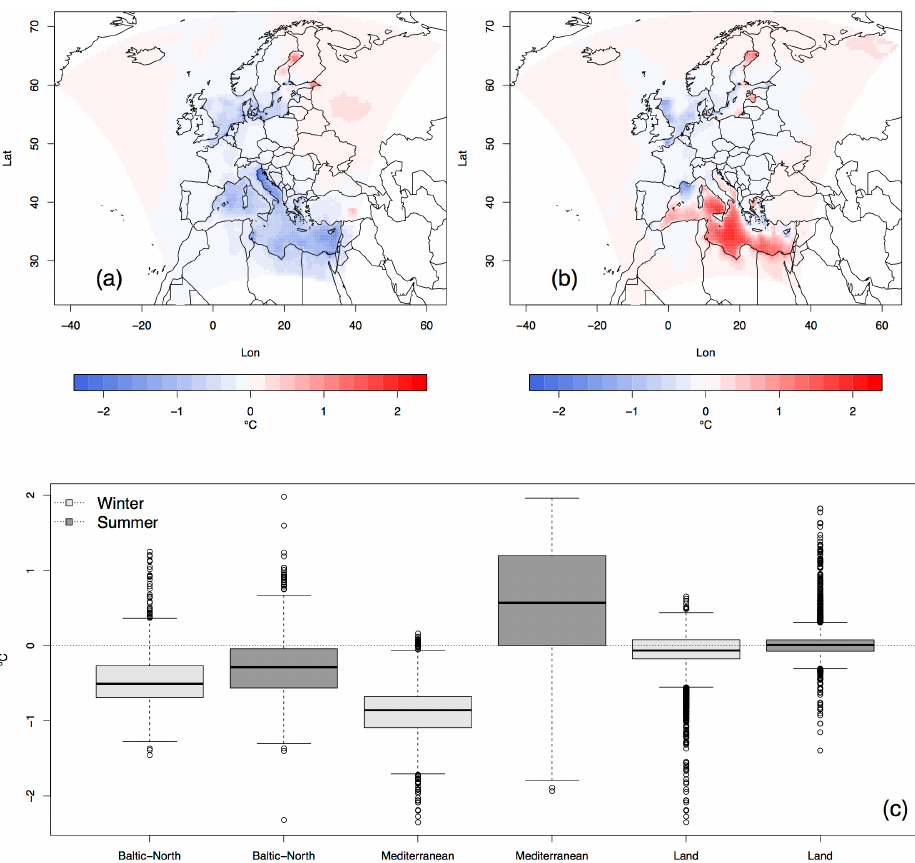
Figure 8. Coupled minus uncoupled simulation 2m air temperature monthly mean ( ◦ C) averaged over the 20th century during winter (a) and summer (b) . Box plots represent the distributions of the monthly mean over the marginal seas and land separately (c) . The box ends at quartiles, the horizontal line represents the median, and the points are values more than 1.5 times the interquartile range from the end of the